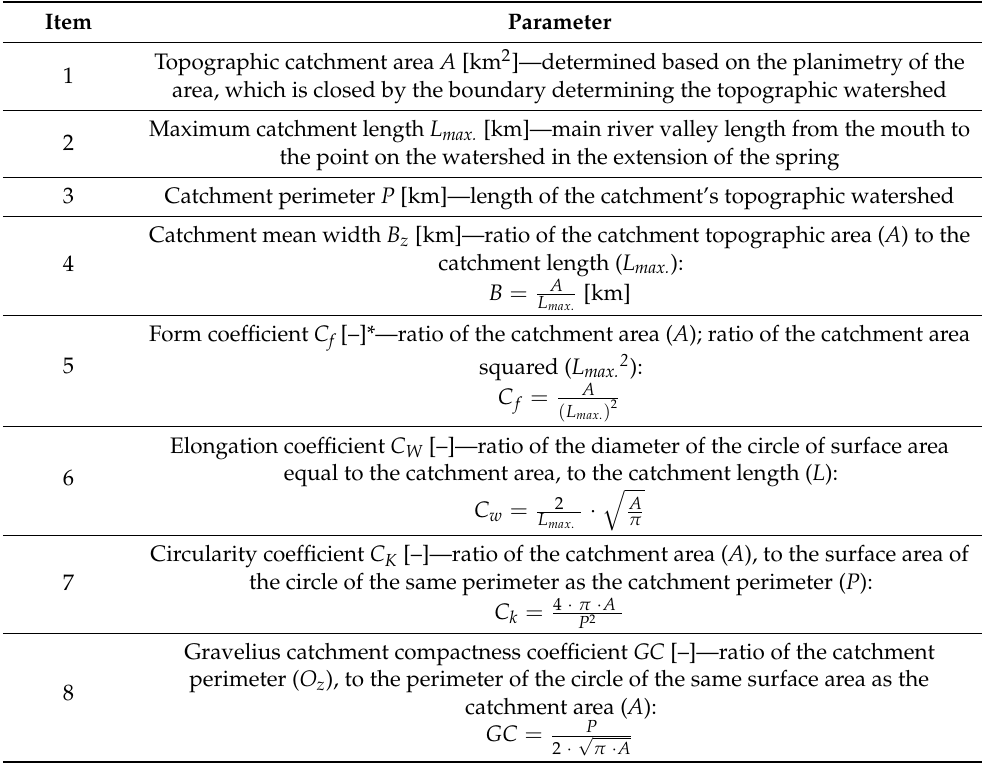
Table 2. Characteristics describing the stream catchment physiographic